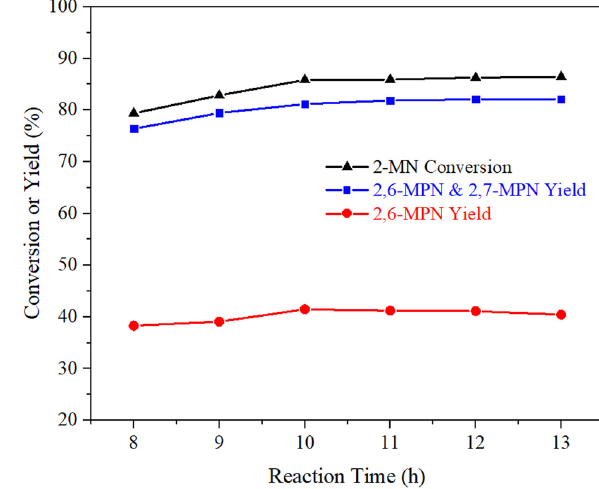
Figure 11: E ff ect of reaction temperature on propionylation of 2 - MN. Reaction conditions: n ( 2 - MN ) : n ( PA ) = 1:1.8, TS 10 g, AlCl 3 /H β ( AlCl 3 3 g · L − 1 , re fl ux for 9 h and calcination at 550°C for 3 h ) 3 g, 10 h.